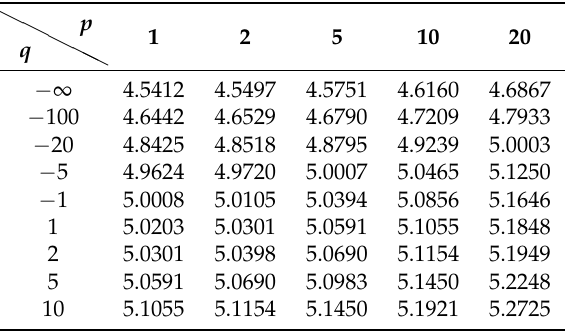
Table 2. ∆ p , q ( P (cid:48) , X 2 ) for several values of p and q